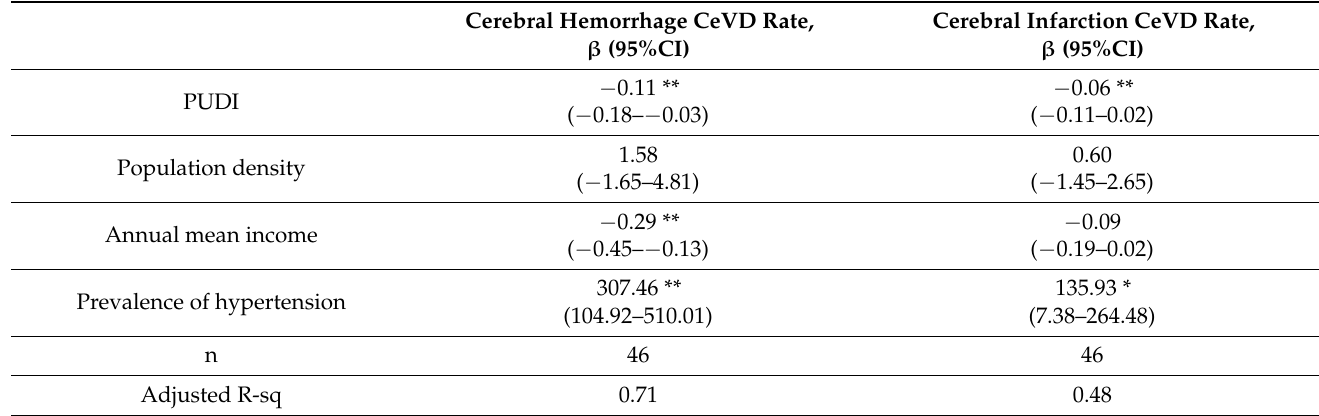
Table 4. Sensitivity analysis: The association between cerebral hemorrhage death rate, cerebral infarction death rate, and Physicians Uneven Distribution Index